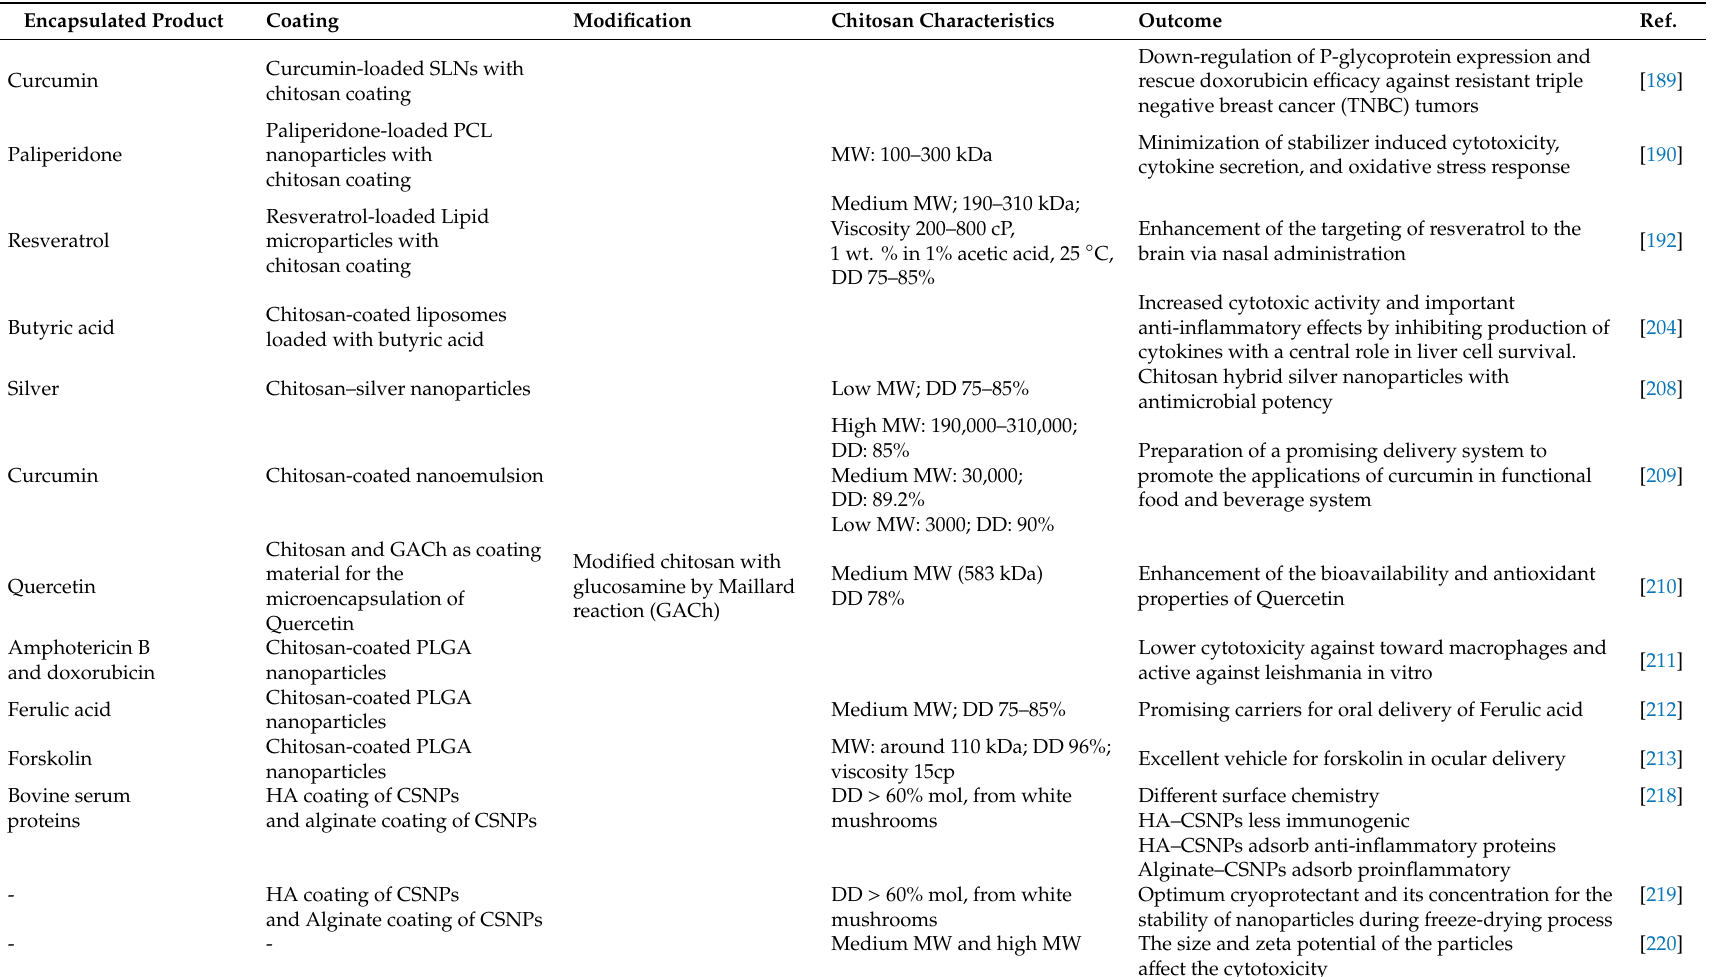
Table 4. Chitosan-coated and modified chitosan nanosystems encapsulating Natural